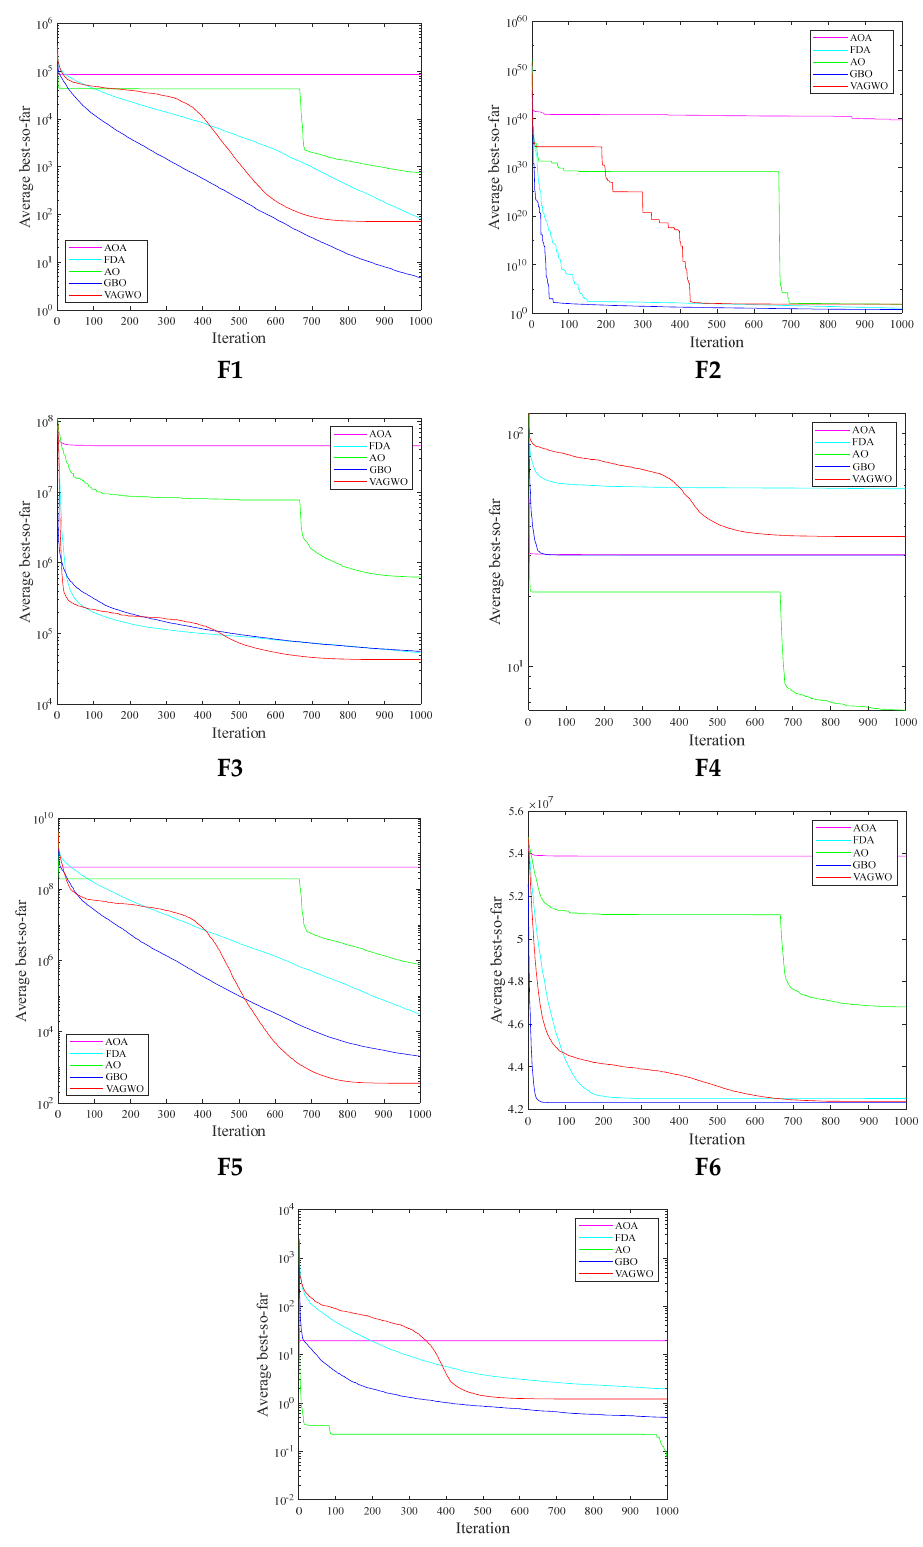
Figure 5. The convergence curves of the VAGWO and the newly proposed algorithms for F1–F7.